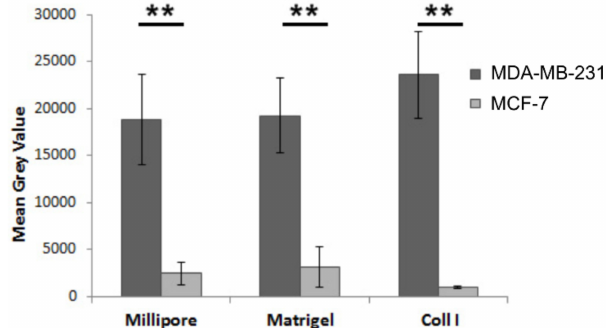
Figure 8. Migration of breast cancer cells cultured on different substrates. MDA-MB-231 and MCF-7 cells were seeded on Millipore filters or Millipore filters covered with Matrigel (0.18 µ g/mL) or collagen type I (Coll I) and incubated for 5 h. All assays were performed as described in Materials and Methods. Asterisks (**) indicate statistically significant differences ( p ≤